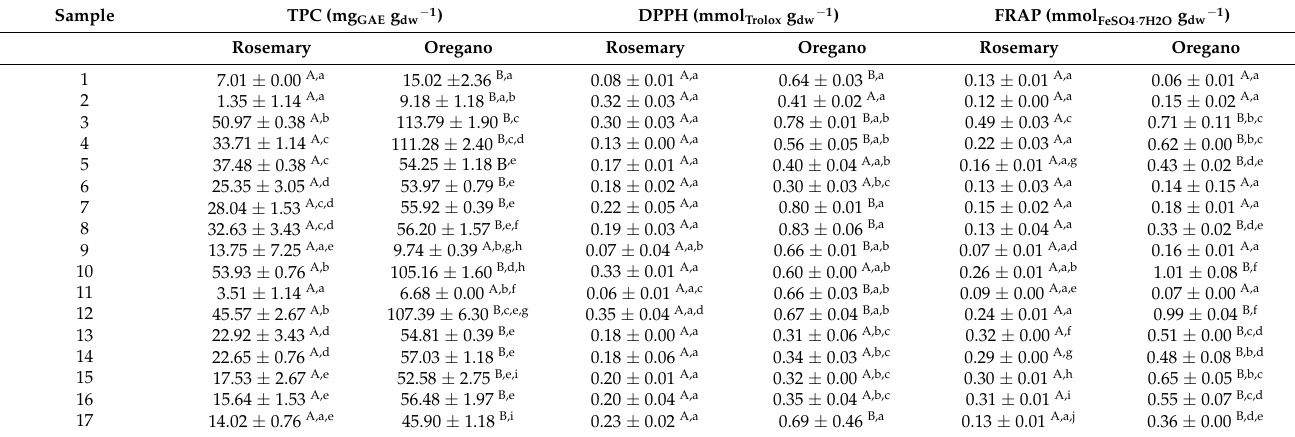
Table 2. Chemical properties of oil-in-water emulsions containing rosemary/oregano extract with the addition of commercial pea protein as emulsifier. A,B The same superscript capital letters within a row denote no significant differences ( p > 0.05) between the values obtained for the different emulsions at the same experimental conditions according to Tukey’s ANOVA. a–j The same superscript lowercase letters within a column denote no significant differences ( p > 0.05) between values obtained for emulsions prepared at different experimental conditions according to Tukey’s